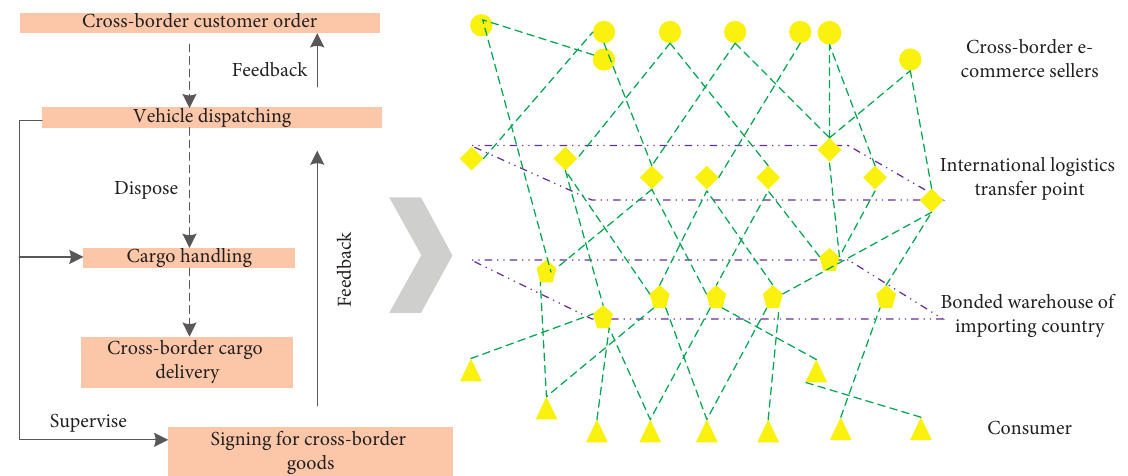
Figure 1: Cross-border e-commerce logistics network node schematic